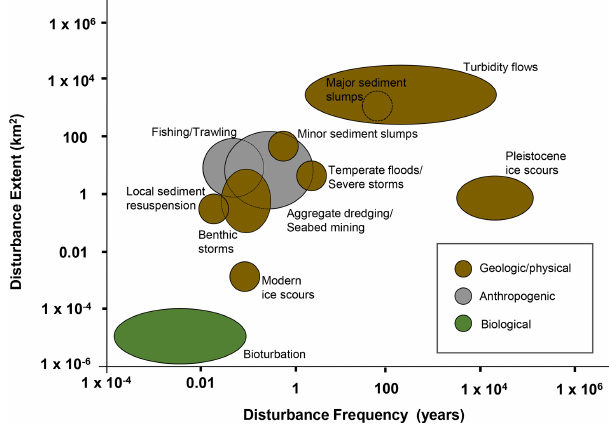
Figure 2. Graph summarizing the frequency (years) and extent patch size (km 2 ) of physical disturbances in the marine environ- ment. Specific data ellipses are not attributed to particular sources because each is based on our interpretation of figures and data from Hall et al. (1994), Glover et al. (2010), Harris (2014), and references